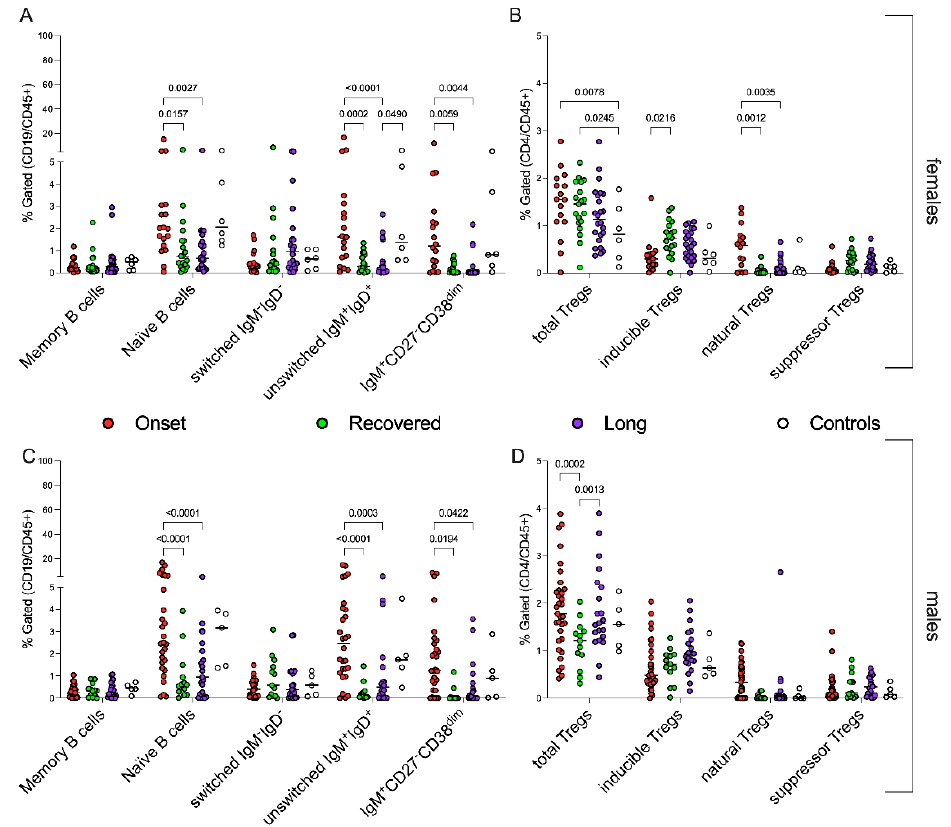
Figure 4. Sex-related B and Tregs subsets, during early/late phases of CoV2 infection. Each circle indicates the percentage of each cell subpopulation or ratio of the different patients/healthy subjects based on the displayed colors: CoV2 -infected children at onset of the disease (red circles), who recovered (green circles), with persistent symptoms (violet circles) and healthy subjects (white circles). The panels ( A , B ) display the sex-related distributions of B-cell subpopulations; the panels ( C , D ) show the percentages of Tregs subsets in the different groups comparing males with females. Statistical analyses were performed with a two-way ANOVA corrected with Tukey.